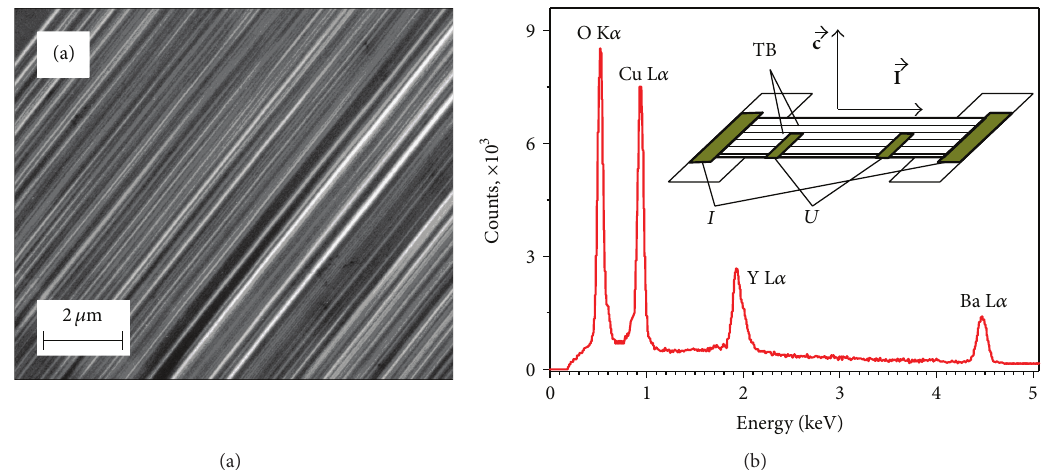
Figure 1: (a) Photograph of the section with unidirectional twin boundaries in the Al-doped crystal K2. (b) Main panel: Material composition in the as-grown pure crystal K1 revealed by energy-dispersive X-ray spectroscopy (probed area of 2 × 2 𝜇 m 2 ). Inset: Geometry of the experiment, see text for